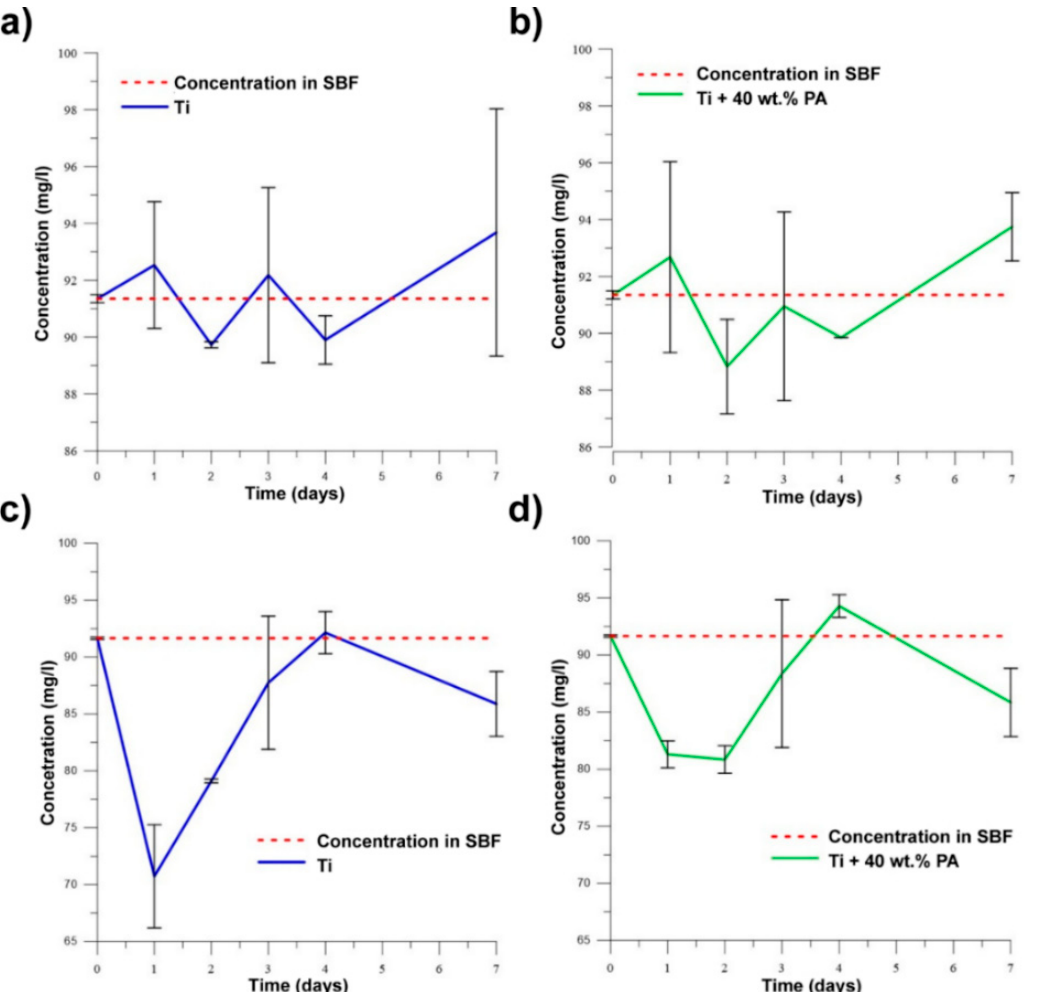
Figure 13. The changes in concentration of (PO 4 ) 3 − for ( a ) Ti; ( b ) Ti + 40 wt.% PA and of Ca 2+ for ( c ) Ti; ( d ) Ti + 40 wt.% PA in SBF.